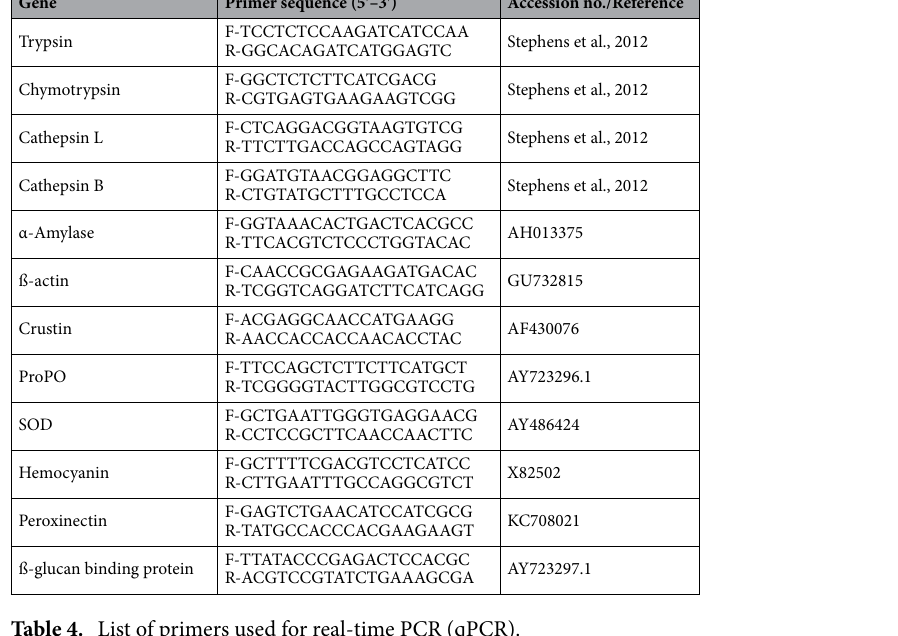
Table 4. List of primers used for real-time PCR